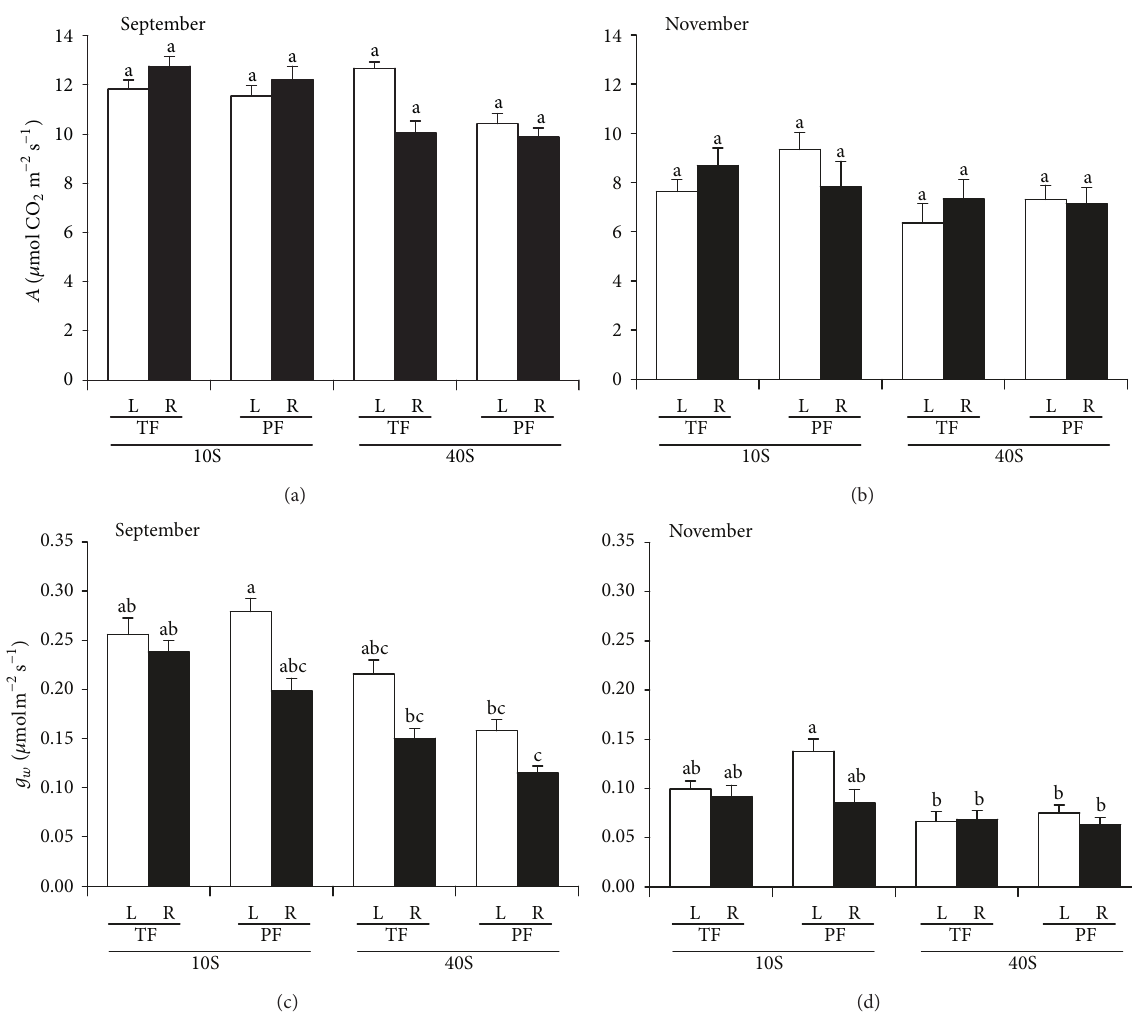
Figure 1: Instantaneous carbon assimilation ( 𝐴 ) and stomatal conductance ( 𝑔 𝑤 ) for Laguncularia racemosa (L) and Rhizophora mangle (R) leaves in response to tidal flooding (TF) or permanent flooding (PF) with 10g/L (10S) or 40g/L (40S) salinity. Data are displayed according to the highest order significant interaction (Table 1). Values are means ± 1SE. Effects annotated with the same letter indicate lack of significance ( 𝑃 > 0.05 ) after Bonferroni adjustment ( 𝛼 = 0.05/12 ) for a particular